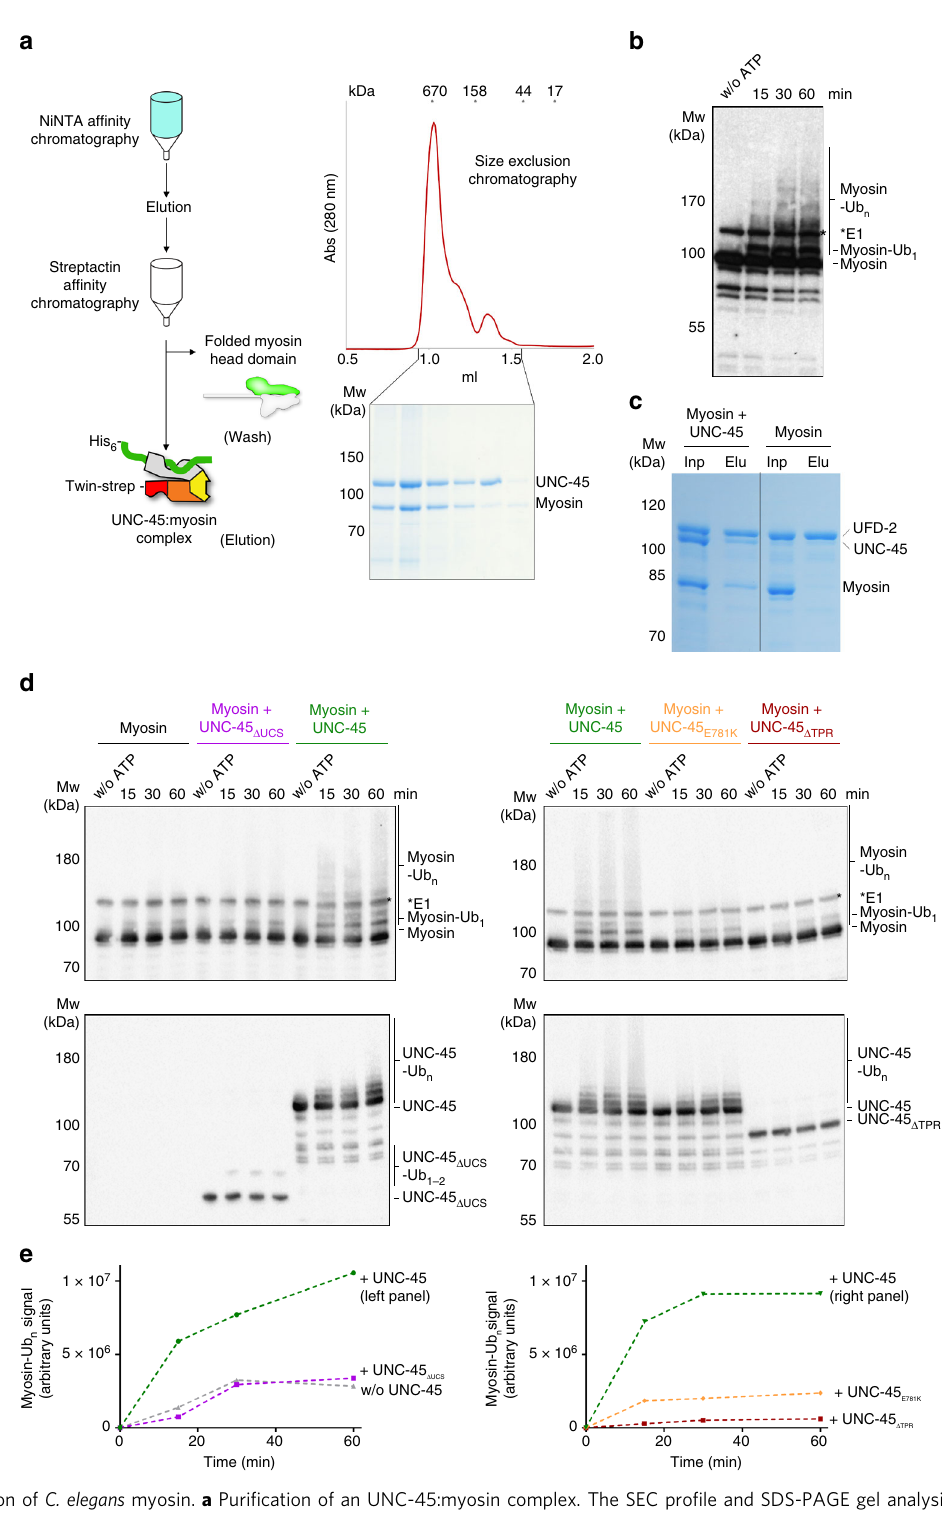
Fig. 7 Ubiquitination of C. elegans myosin. a Puri fi cation of an UNC-45:myosin complex. The SEC pro fi le and SDS-PAGE gel analysis of the fi nal sample point to a stoichiometric UNC-45:myosin complex. b Time-course analysis of the ubiquitination of the puri fi ed UNC-45:myosin complex by UFD-2. c Pull- down analysis showing the interaction of UFD-2, UNC-45, and myosin, yielding a ternary complex. The control pull-down without UFD-2 is shown. d Ubiquitination of puri fi ed, heat-treated myosin (MHC-B) in the presence of UNC-45, UNC-45 Δ UCS , UNC-45 E781K , and UNC-45 Δ TPR . Reactions were incubated for 15, 30, and 60 min with ATP and a control reaction for 60 min without ATP, and analyzed by anti-His (upper panel) and anti-UNC-45 (lower panel) western blot. e Quanti fi cation of ubiquitinated myosin, using the same color code as in d . The ubiquitination signal observed without ATP was used for background subtraction and is displayed as time point 0 for every reaction